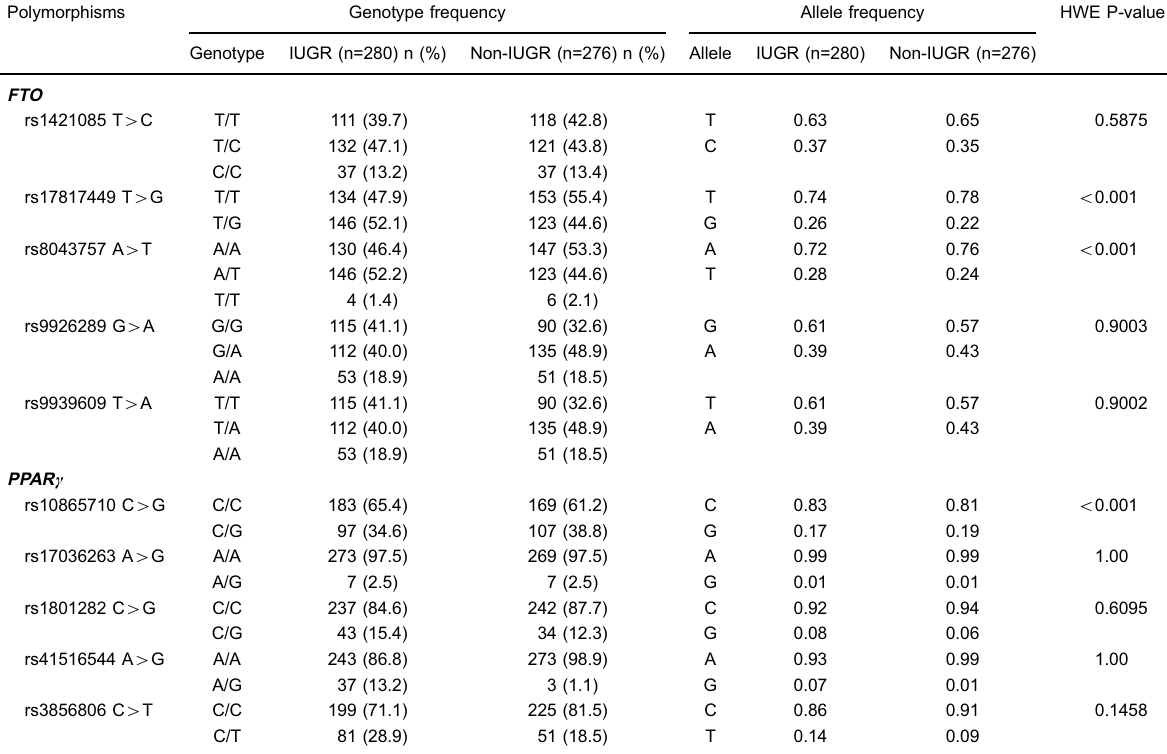
Table 2. Genotype and allele frequencies of the polymorphic single-nucleotide polymorphisms (SNPs) from FTO (fat mass and obesity-associated) and PPAR g (peroxisome proliferator-activated receptor-gamma) genes in intrauterine growth restriction (IUGR) and control